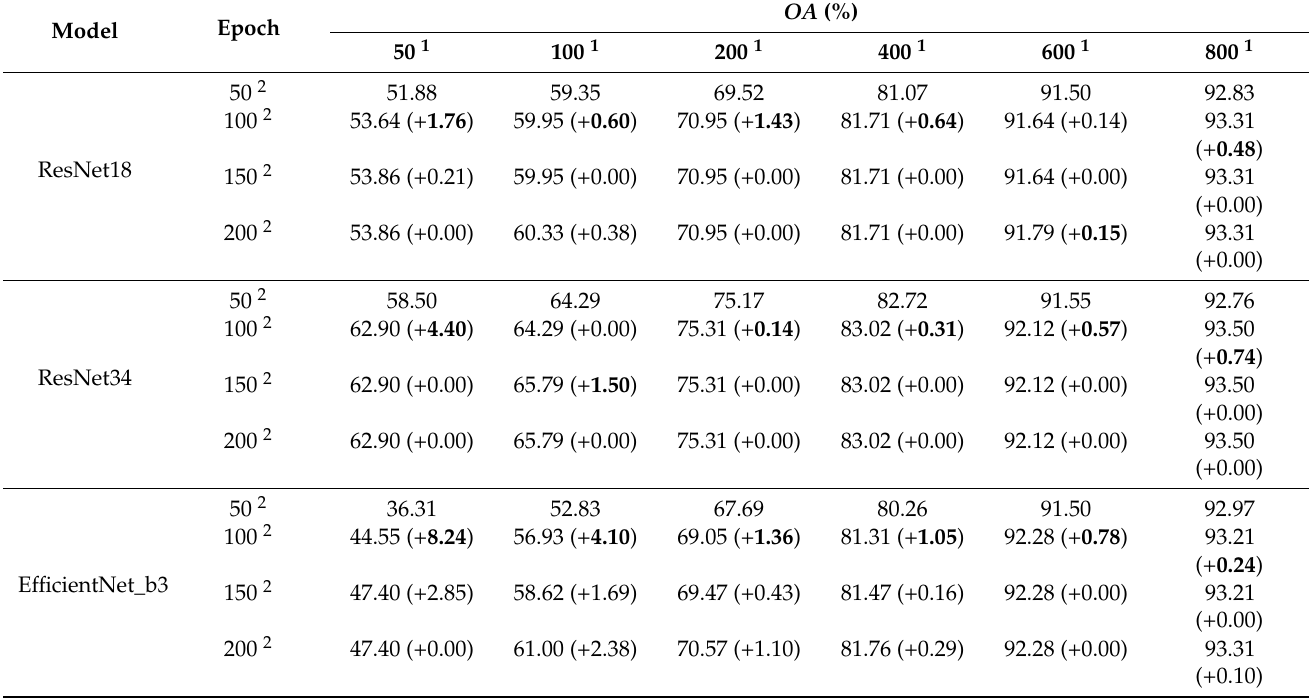
Table 2. The overall accuracy of the different models with different training epochs.